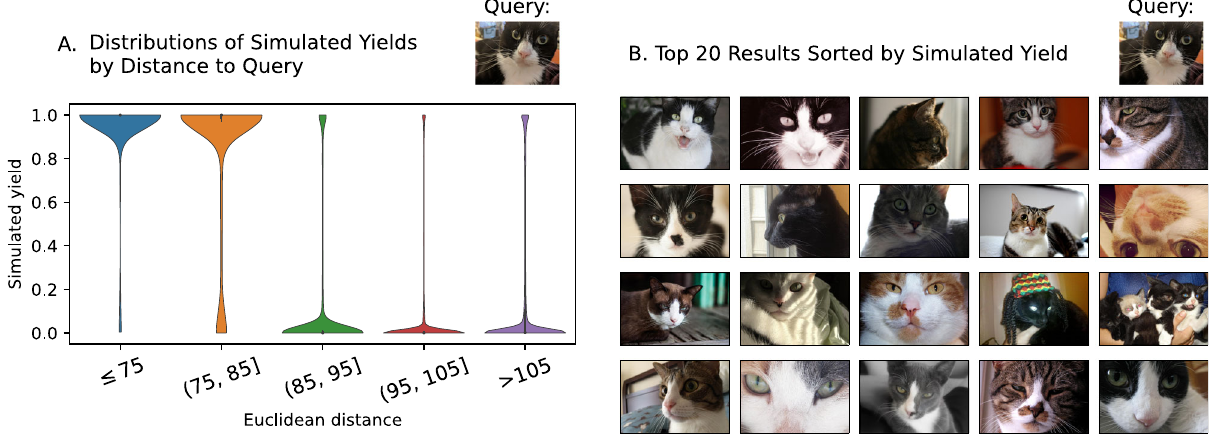
Fig. 5 Results of a NUPACK simulation of using a query image of a cat with a larger database consisting of 5.5 million images. A Distributions of simulated yields for each target image, categorized by their feature vectors ’ Euclidean distances to the query feature vector. The widths of each violin are normalized to be equal. B The top 20 images in the database, sorted by the NUPACK-simulated yield of the reaction between their encoded DNA representation and the reverse complement of the query ’ s DNA